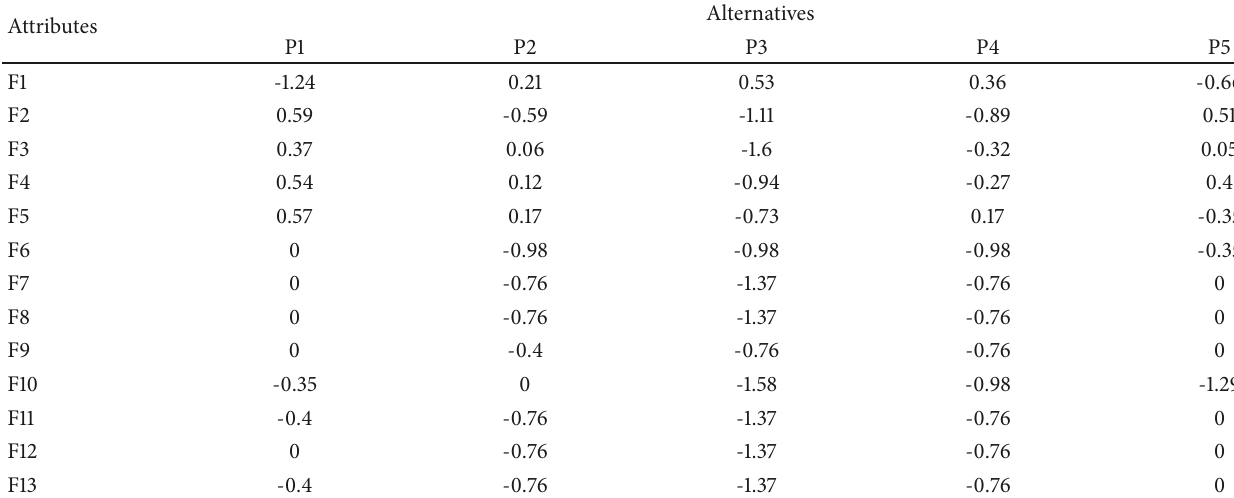
Table 4: Online channels, property prospect